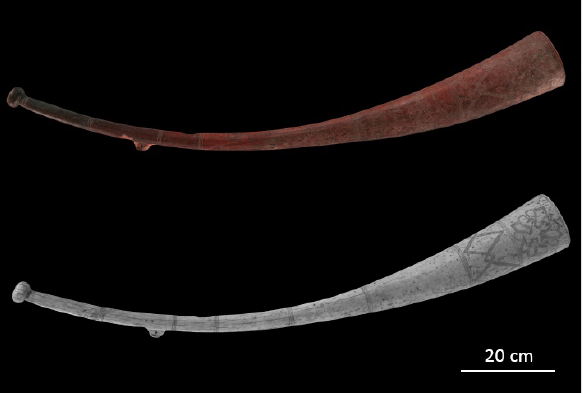
Figure 3: General view of the 3D model of the horn in visible light on top (https://sketchfab.com/3d-models/mo196763802- 3e9f6aae6bde4c269bf36795f15ab1d5) and in infrared on the bottom (https://sketchfab.com/3d-models/mo196763802- 950nm-ce3d430f695b4e43af9e991d59676956). The engravings are more clearly visible on the IR